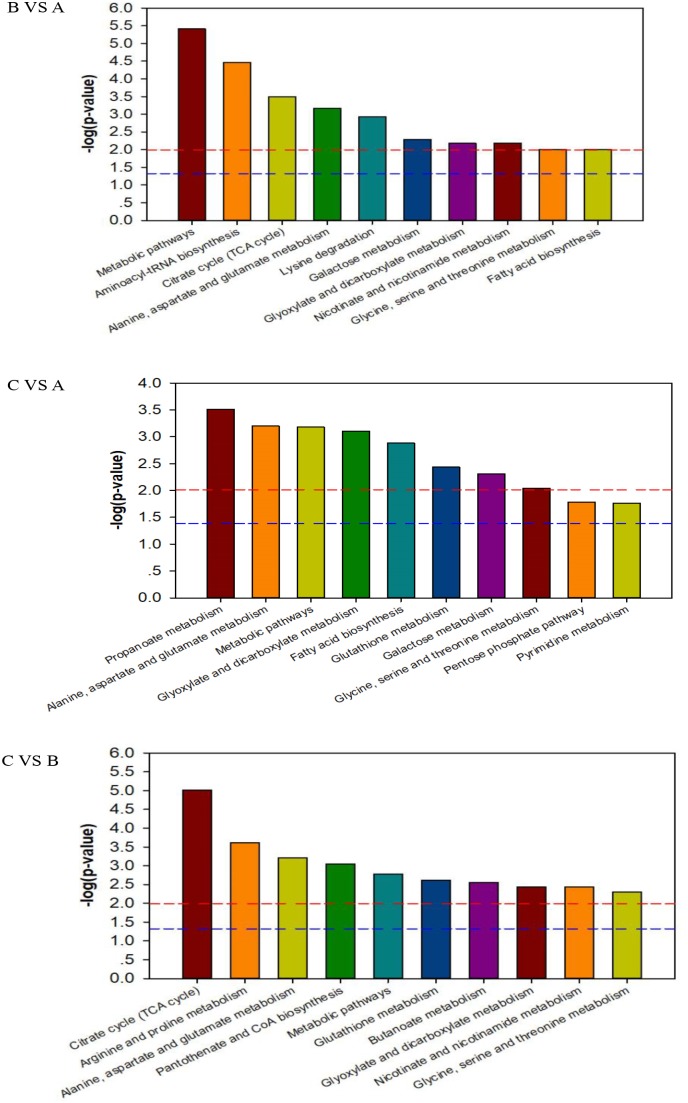
The KEGG pathway enrichment analysis of differential metabolites between Mycelia B samples versus Mycelia A samples (B vs. A), Mycelia C samples versus Mycelia A samples (C vs. A), and Mycelia C samples versus Mycelia B samples (C vs. B). Each comparison mycelia only shows top 10 enrichments pathways of differential metabolites. P-value was calculated using Fisher’s exact test.